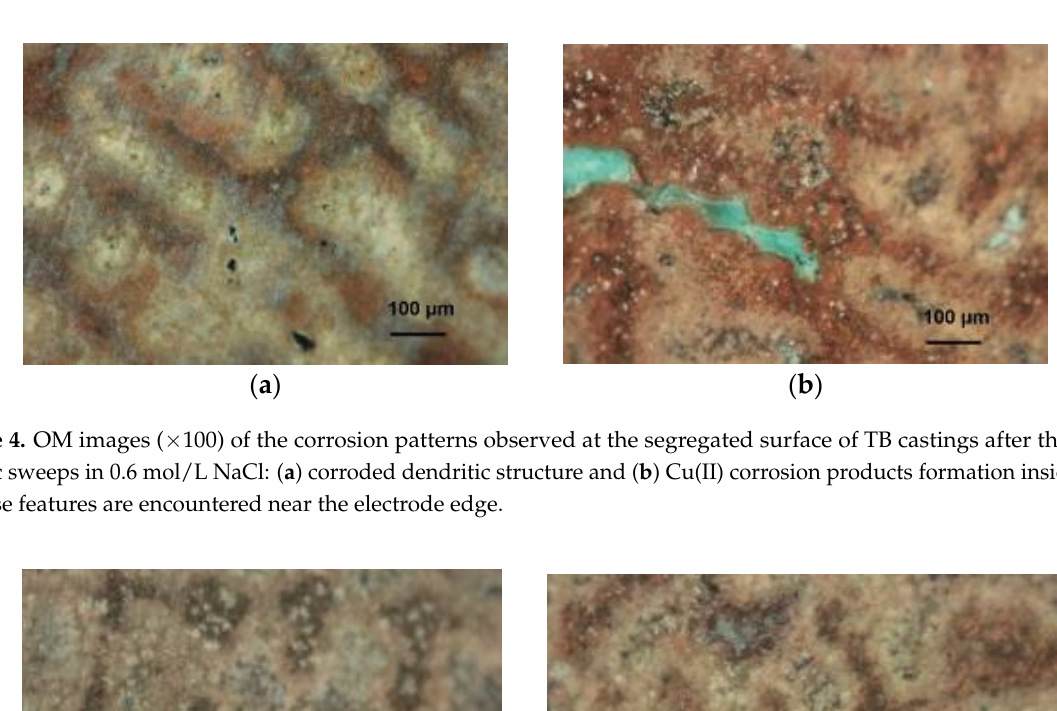
Figure 3. Anodic polarization curves (OCP+ 0.6 V) acquired in the three corrosive media at a typical scan rate of 1 mV/s, after 1 h at OCP conditions. Data first presented in [28].